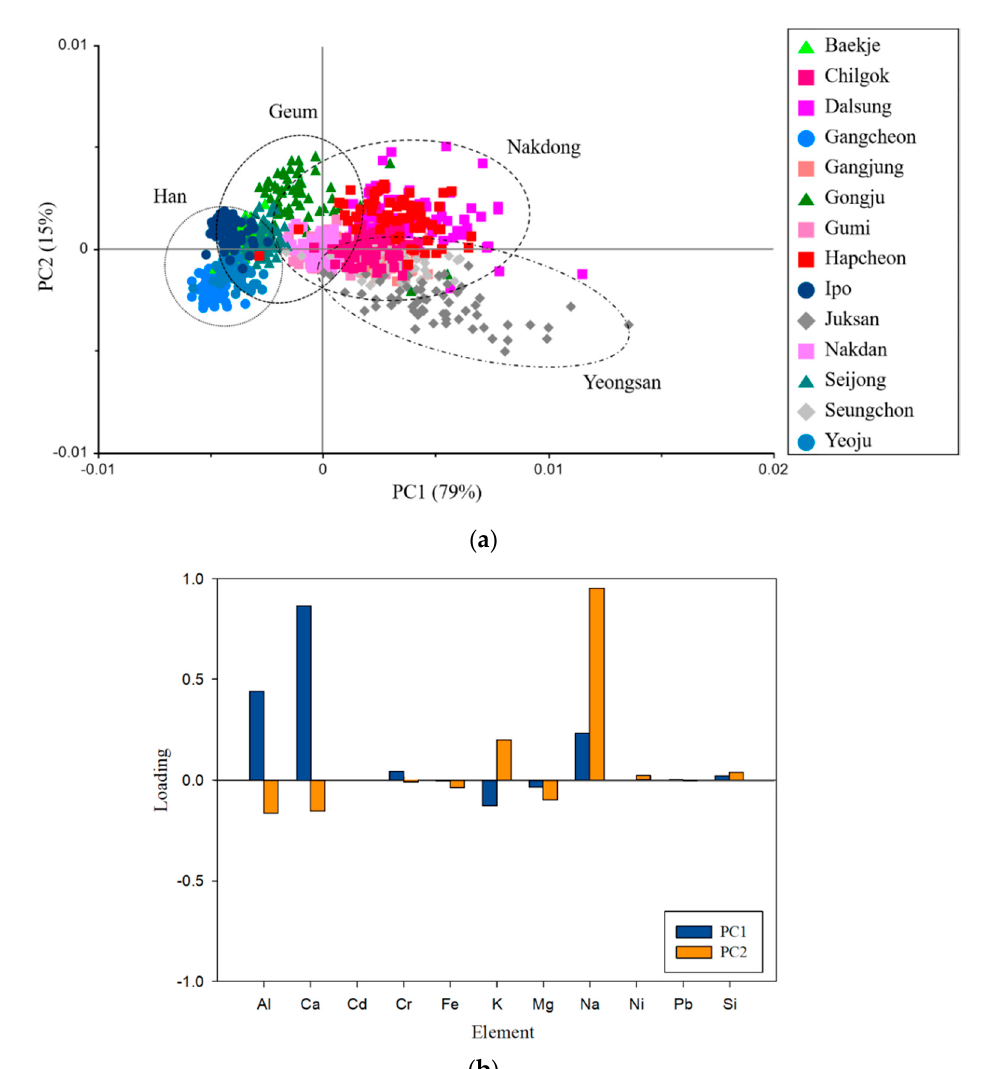
Figure 5. Score ( a ) and loading ( b ) plots of first two PCs from the PCA on the LIBS spectra at the selected lines of sediment samples.